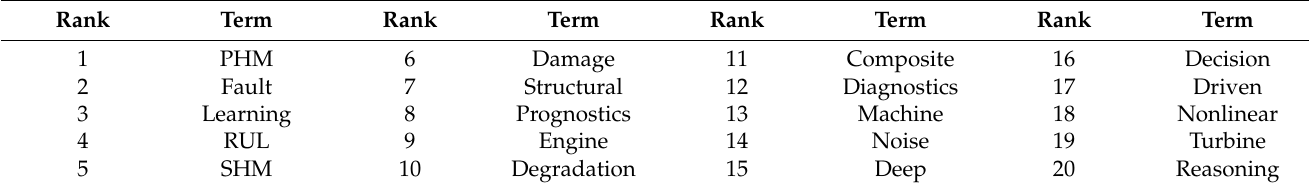
Table 1. Fifty recent review publications analysed using TF-IDF with terms ranked in order by the highest total score for all papers across the entire corpus.